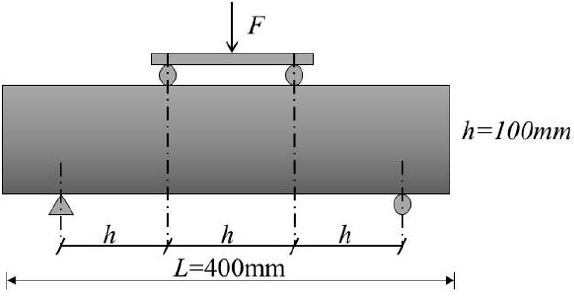
Figure 5. Schematic diagram of flexural strength test.